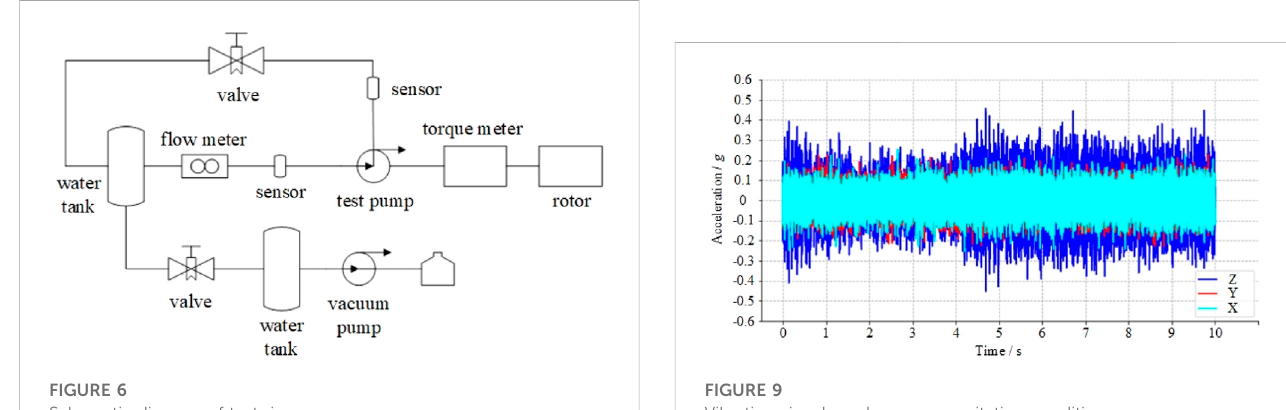
FIGURE 6 Schematic diagram of test rig.